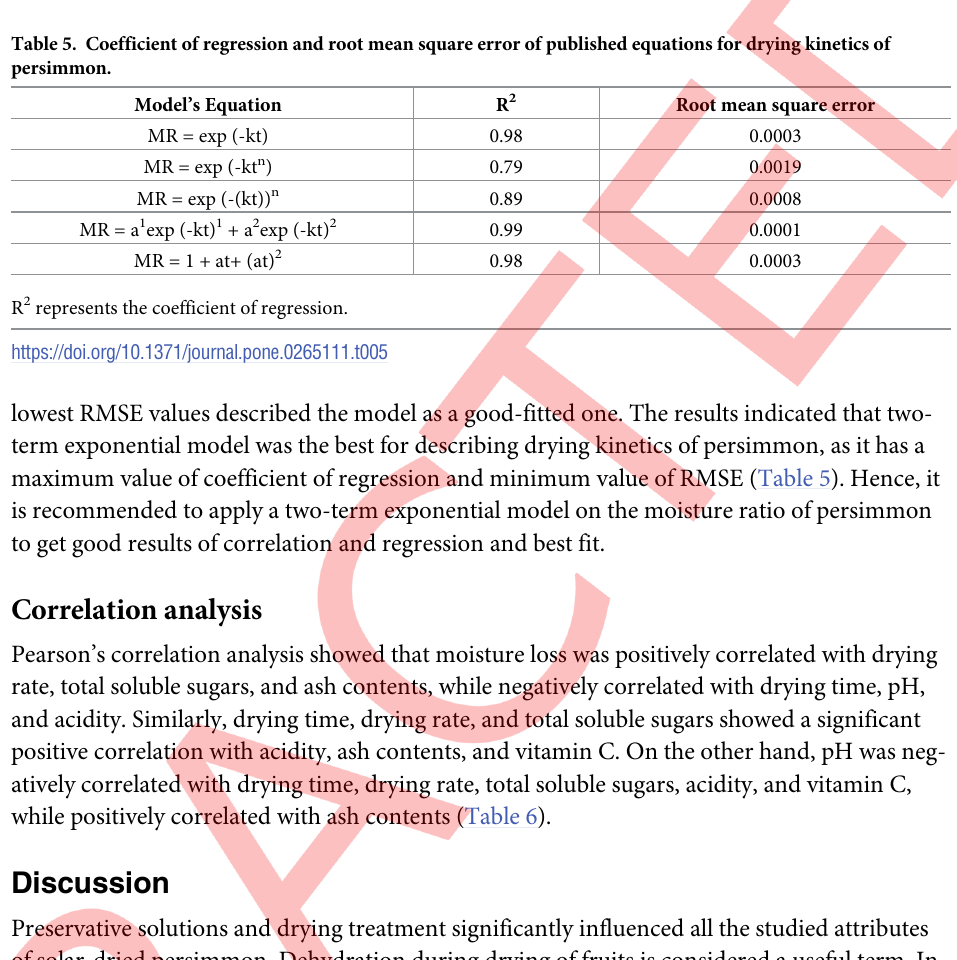
for longer period. Furthermore, increased shelf life through dehydration would help in long distance transport of fruits. Solar drying helps to evaporate most of the moisture where only soluble solids are left. However, very high temperature beyond 50˚C would result in more humid condition around the fruits which will expose the fruits to microorganisms [39]. Table 6. Pearson’s correlation analysis among different organoleptic quality attributes of persimmon fruit treated with preservatives and dried under different temperatures. Moisture loss Drying time Drying rate Total soluble sugars pH acidity Vitamin C